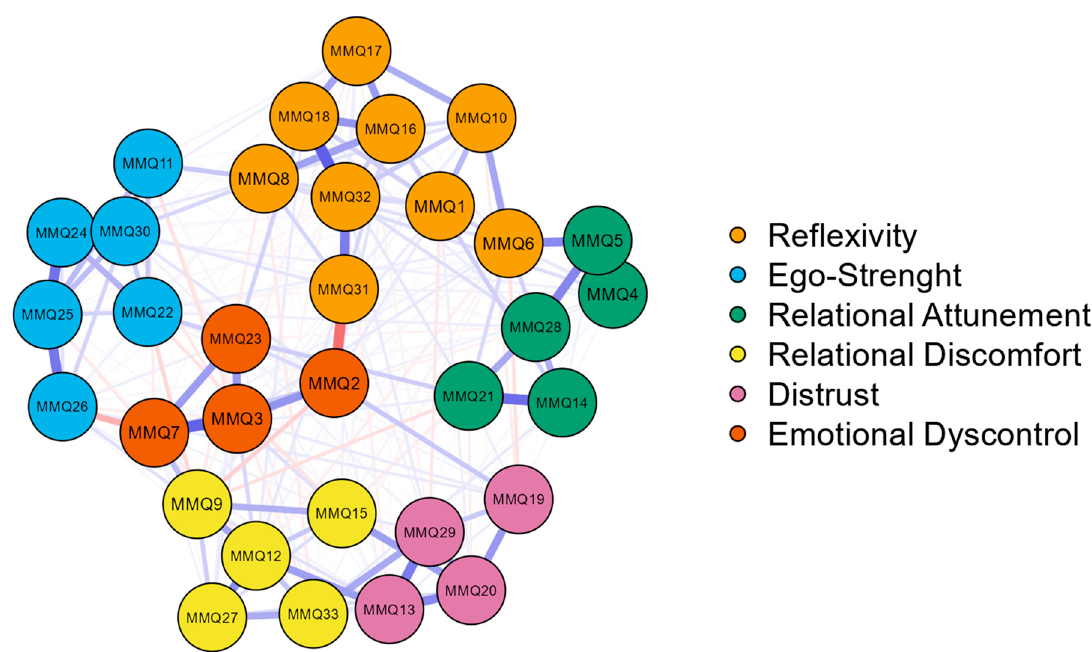
Figure 4. Gaussian graphical model for the Multidimensional Mentalizing Questionnaire: the network structure. Note: Red lines indicate negative associations between items; blue lines indicate positive associations between items; thicker lines indicate stronger edge weights.